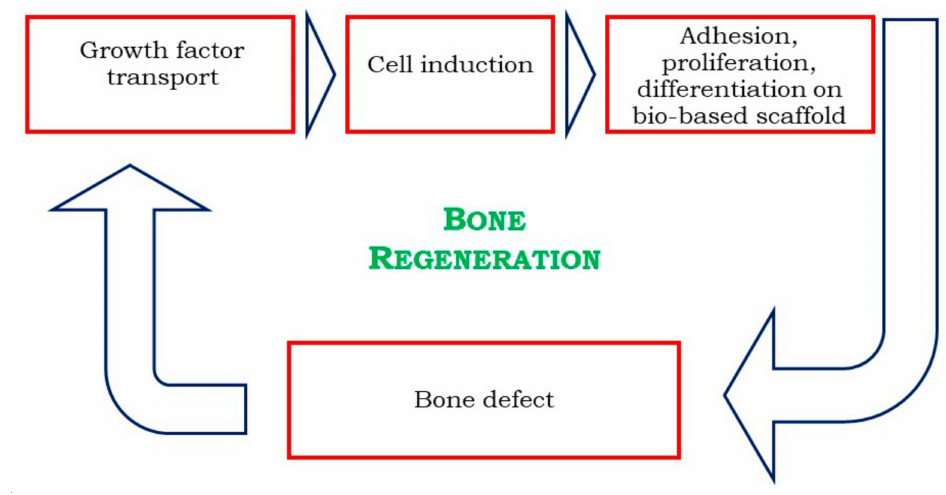
Figure 5. Bone regeneration (BR) through TE, adapted from Bhattacharya et al.